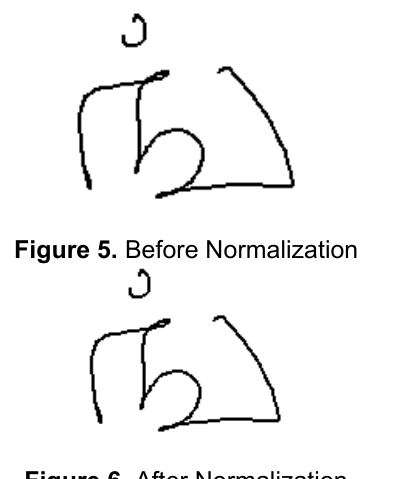
Figure 6. After Normalization